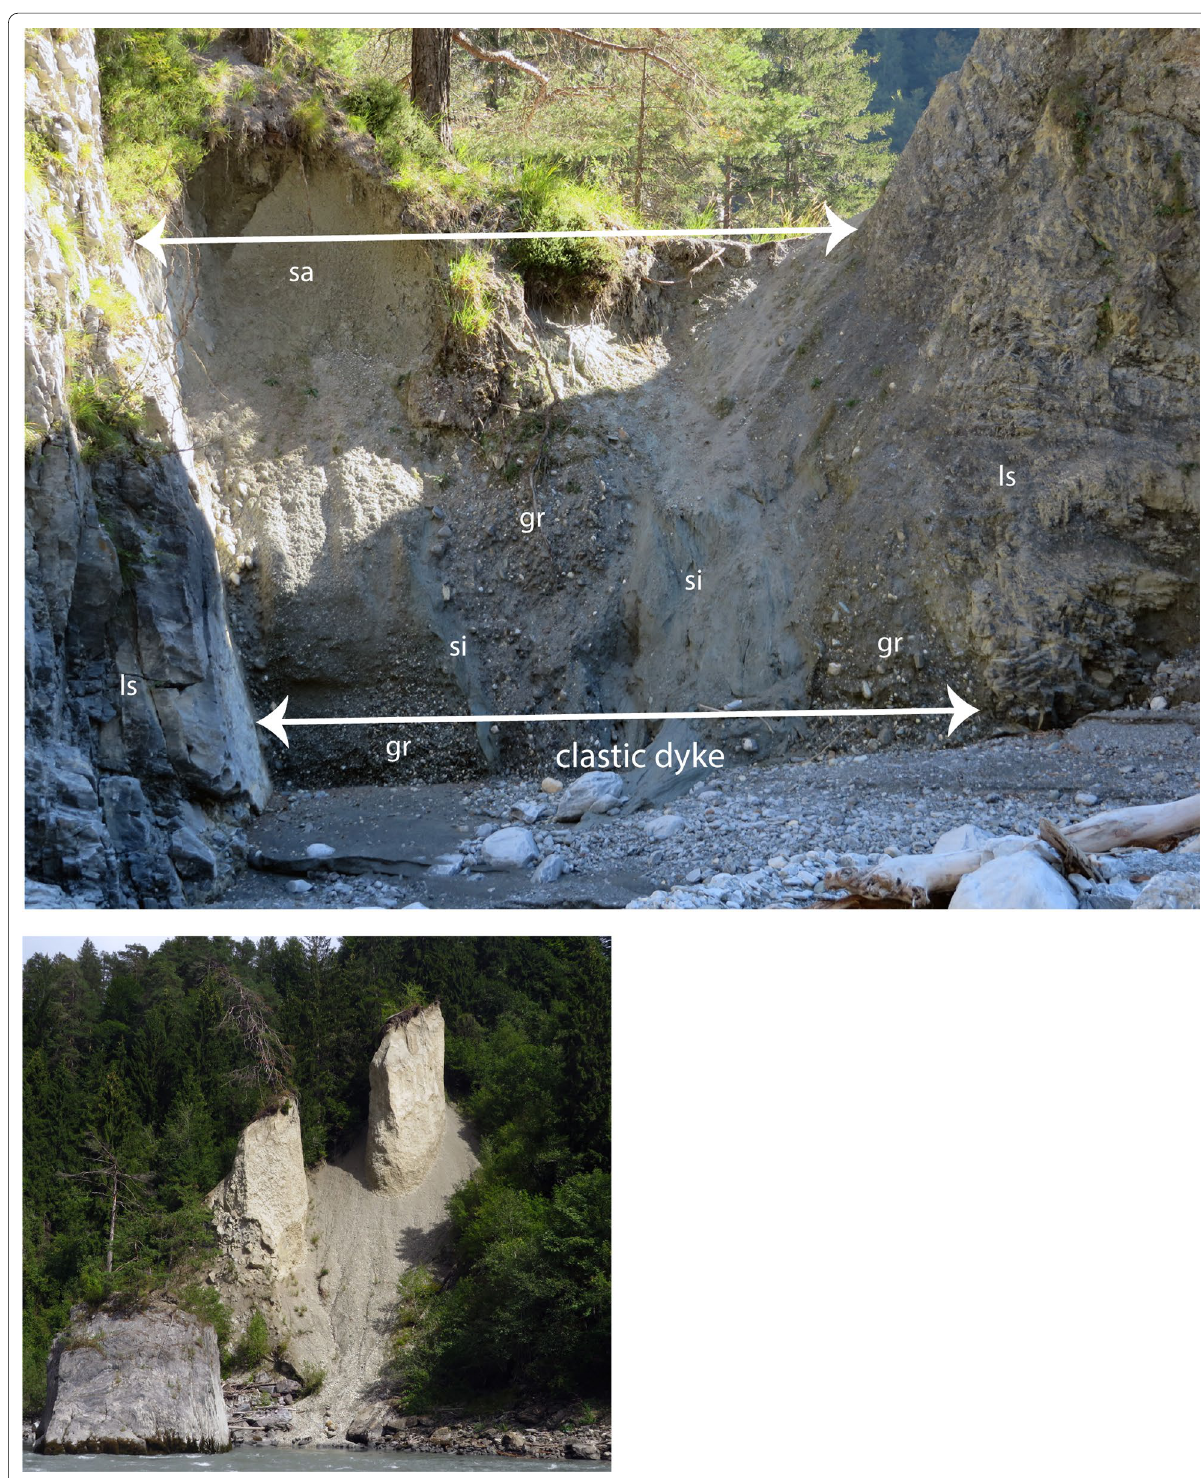
Fig. 12 Injection of substrate into the rock avalanche deposit. A Clastic dyke in Val Pintrun (coord. 2745380/1186500) displaying vertically layered gravel (gr), sand (sa) and silt (si) between limestone compartments (ls) of the rock avalanche deposit. B Two gravel pilars 250 m east of railroad station Trin. The pilar on the left is in vertical contact wtih rock avalanche